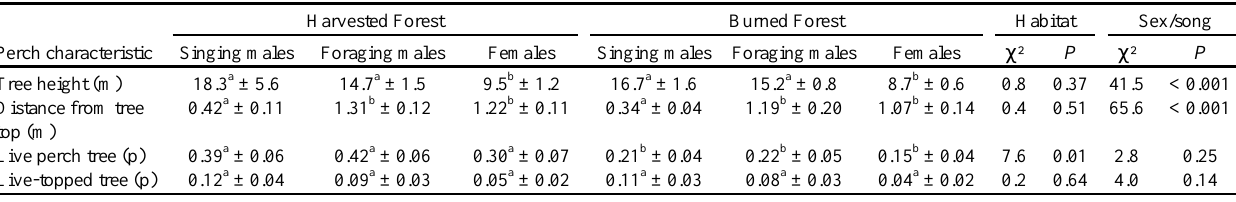
Table 1 . Characteristics of trees used as perches by Olive-sided Flycatchers ( Contopus cooperi ) in northwestern Montana as a function of habitat type (burned vs. selectively harvested forest) and whether perching individuals were (1) singing males, (2) foraging males, or (3) foraging females. Wald c ² values and their associated P-values are derived from generalized estimating equation models. Parameter estimate are given with their standard errors. Marginal mean values for perch tree height (meters) and the distance below the tree top at which a flycatcher perched (meters) are listed. The marginal probabilities (p) of a perch tree being (1) partially alive vs. entirely dead (a snag) and (2) having a minimum 0.5 m dead portion at its apex are given. Sex/ foraging-group specific values for a focal perch characteristic that share a superscript letter are not significantly different. Harvested Forest Burned Forest Habitat Sex/song Singing males Foraging males Females Singing males Foraging males